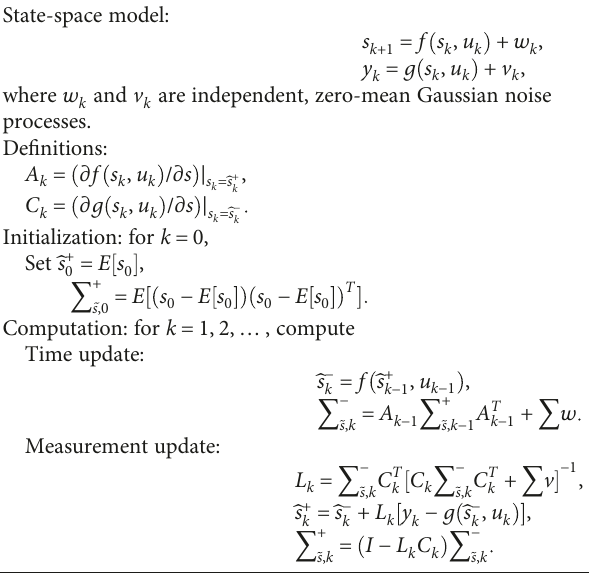
Table 1: Summary process of the